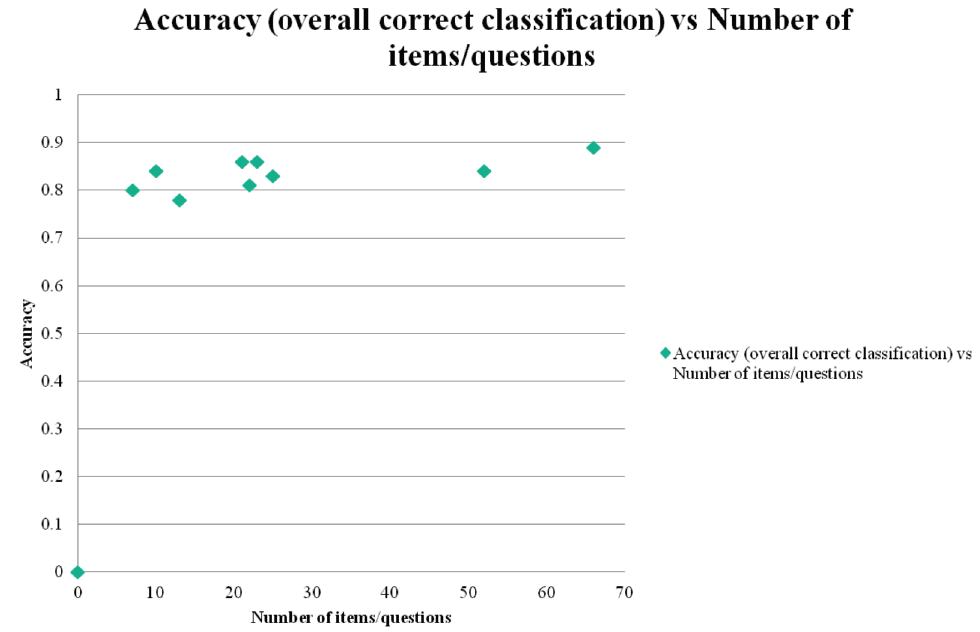
Figure 2. Scatter plot of test correct classification accuracy versus total number of test items/questions (= surrogate measure of test administration